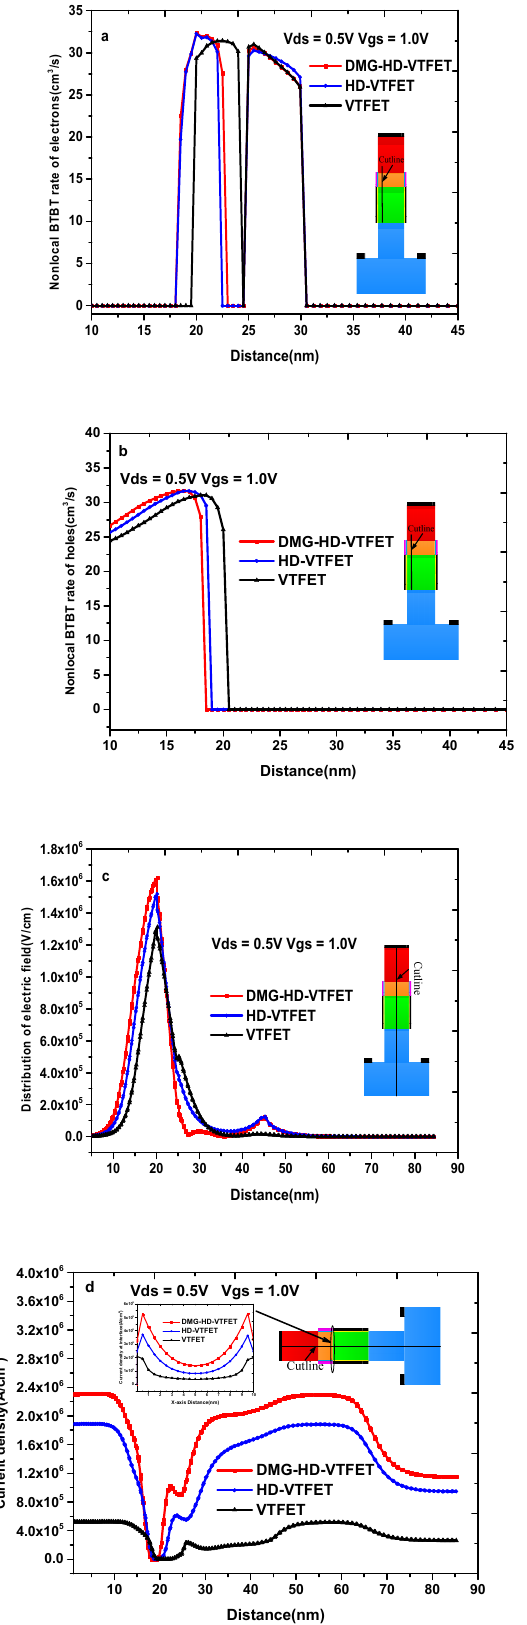
Figure 3. ( a ) Electrons’ nonlocal band-to-band tunneling (BTBT) rate; ( b ) holes’ nonlocal band-to-band tunneling (BTBT) rate; ( c ) electric field distribution; and ( d ) total current density of VTFET, HD-VTFET, and DMG-HD-VTFET. Figure 4a illustrates the ON-state (drain - to - source voltage (Vds) = 0.5 V, gate-to-source voltage (Vgs) = 1 V) energy band diagram of VTFET, HD-VTFET, and